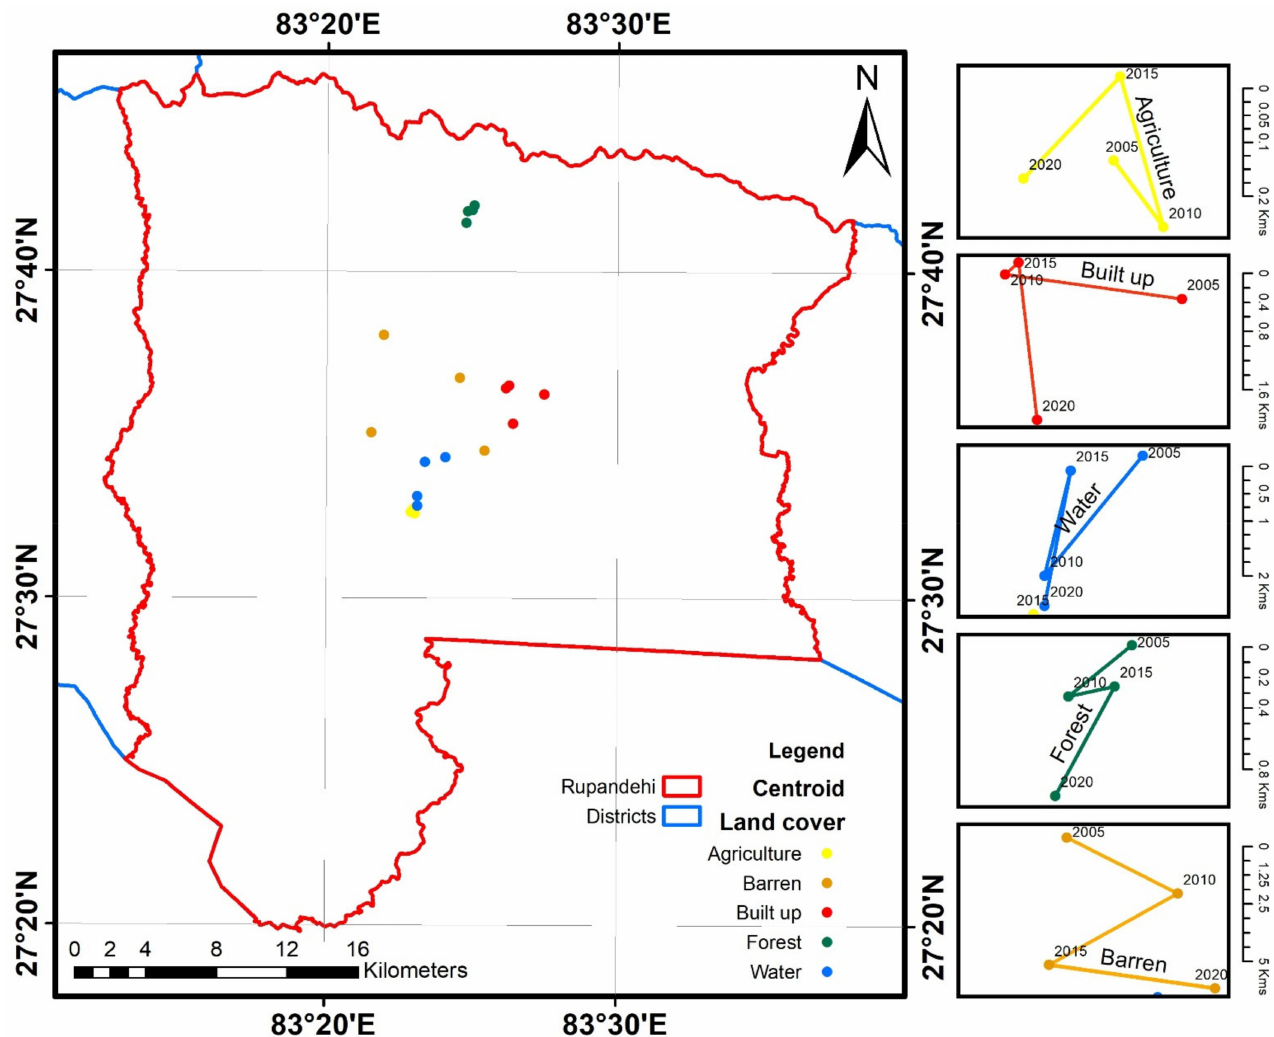
Figure 7. Centre of gravity and their shifts for all LCs in Rupandehi District with five years intervals. Note the space of shifts is